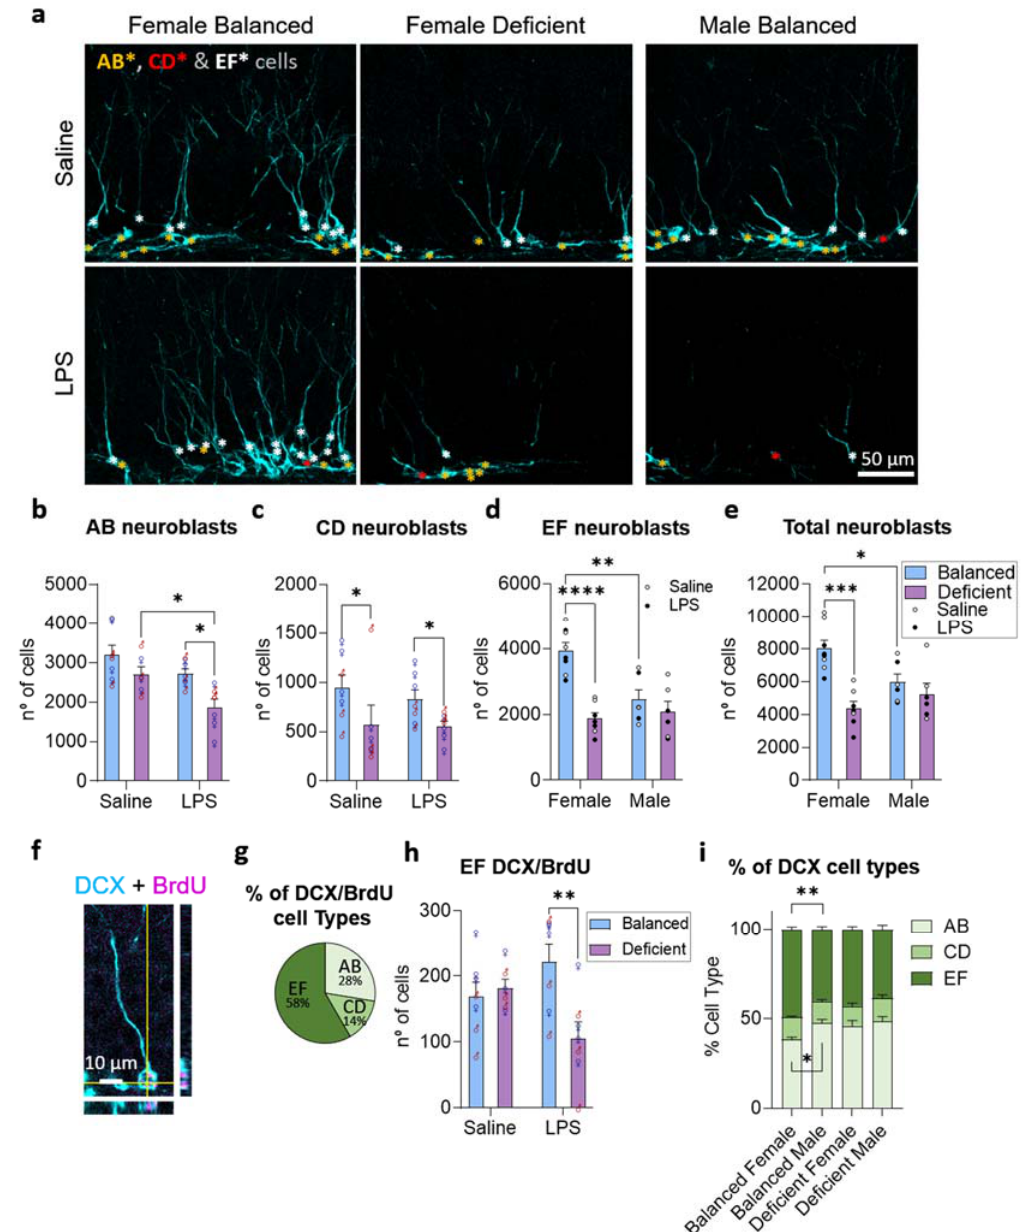
Figure 4. The n ‐ 3 PUFA ‐ deficient diet reduced the number of neuroblasts in the dentate gyrus. ( a ) Confocal images (maximum intensity projections, z = 13.8 μ m) of the dentate gyrus (DG) of the hippocampus showing neuroblasts expressing doublecortin (DCX, cyan) in female mice fed with the balanced or n ‐ 3 PUFA ‐ deficient diets and treated with saline or LPS, and in male mice fed with the balanced diet and treated with saline or LPS. Different types of neuroblasts according to their morphology and maturation stage are identified with colored asterisks (early neuroblasts: AB cells in yellow, intermediate neuroblasts: CD cells in red, and young neurons: EF cells in white). ( b ) The n ‐ 3 PUFA ‐ deficient diet and LPS treatment significantly reduced the number of early (AB) neuroblasts in the hippocampus (no effect of sex and no interaction between diet and LPS treatment detected). ( c ) Mice fed with the n ‐ 3 PUFA ‐ deficient diet showed a reduced number of intermediate (CD) neuroblasts (no effect due to LPS treatment or sex detected). ( d ) Female mice fed with the n ‐ 3 PUFA balanced diet showed a higher number of young neurons (EF neuroblasts) than males fed